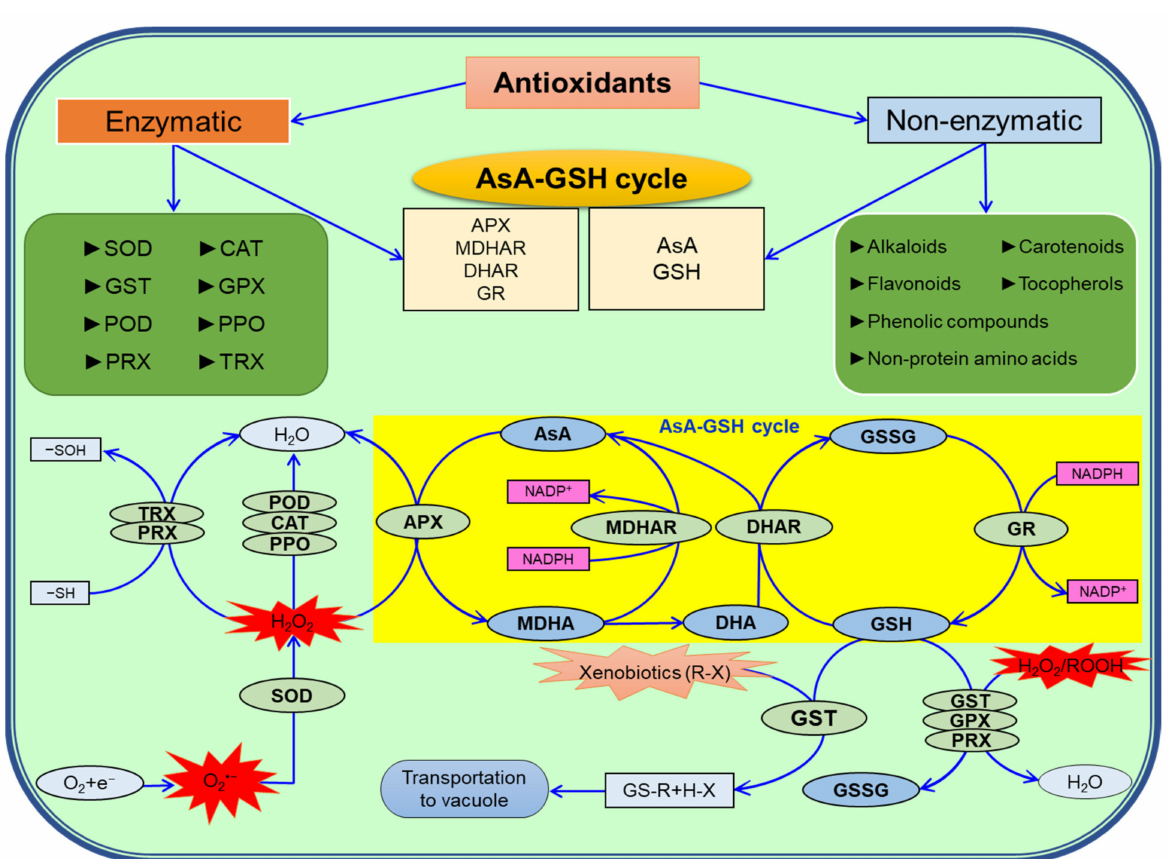
Figure 7. Overview of different types of antioxidants and their combined mechanisms [2]. Detail descriptions are provided in the text. SOD—superoxide dismutase; CAT—catalase; POX—peroxidases; AsA—ascorbate; DHA—dehydroascorbate; GSSG—oxidized glutathione; GSH—reduced glutathione; APX—ascorbate peroxidase; MDHA—monodehydroascorbate; MDHAR—monodehydroascorbate reductase; DHAR—dehydroascorbate reductase; GR—glutathione reductase; GST— glutathione S -transferase; GPX—glutathione peroxidase; PPO—polyphenol oxidase; PRX—peroxiredoxins; TRX— thioredoxin; NADPH—nicotinamide adenine dinucleotide phosphate; O 2 —oxygen; e − —electrons; H 2 O 2